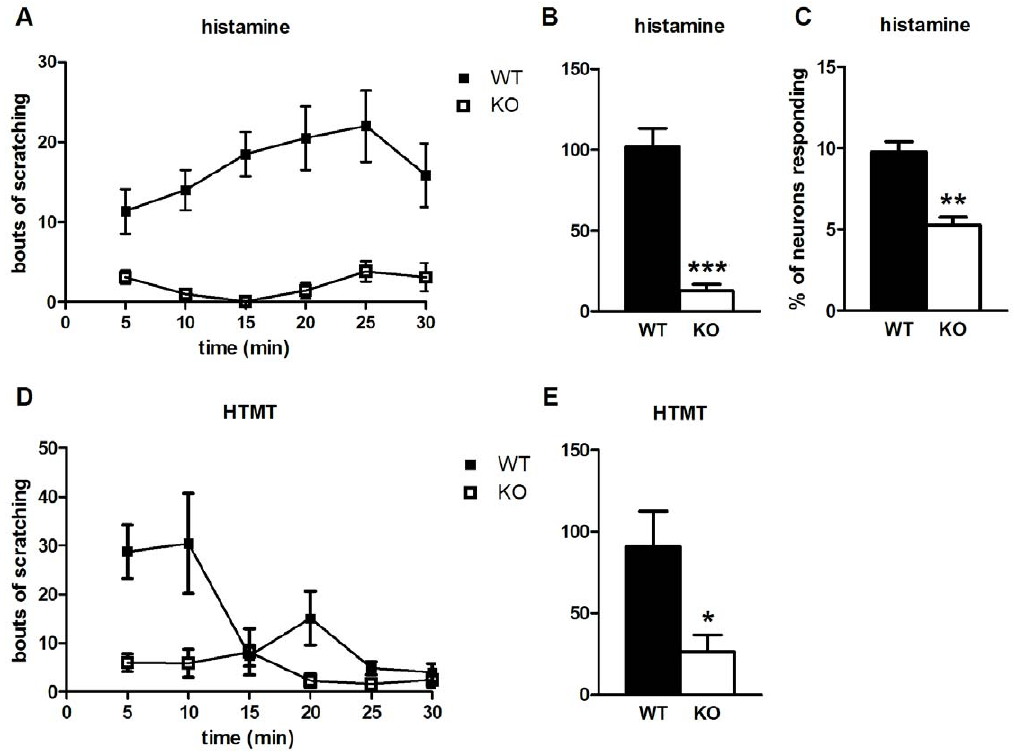
Figure 1. Pirt contributes to histaminergic itch. ( A ) The time course shows scratching bouts, presented as mean 6 SEM, in response to histamine injection (10 m mol) over a 30 min period divided into 5 min intervals. ( B ) Total bouts of scratching over the 30 min observation period show Pirt 2 / 2 mice (n=7) have decreased behavioral responses to histamine compared to WT mice (n=8). ( C ) Ca 2 + imaging shows fewer DRG neurons from Pirt KO mice respond to histamine (50 m M) than WT mice (n=5 per genotype). ( D , E ) Pirt mutant mice (n=10) also scratch less upon injection of the histamine H1 receptor-selective agonist HTMT (0.1 m mol) than WT (n=9). * p , 0.05, ** p , 0.001, *** p , 0.0001; two-tailed unpaired t